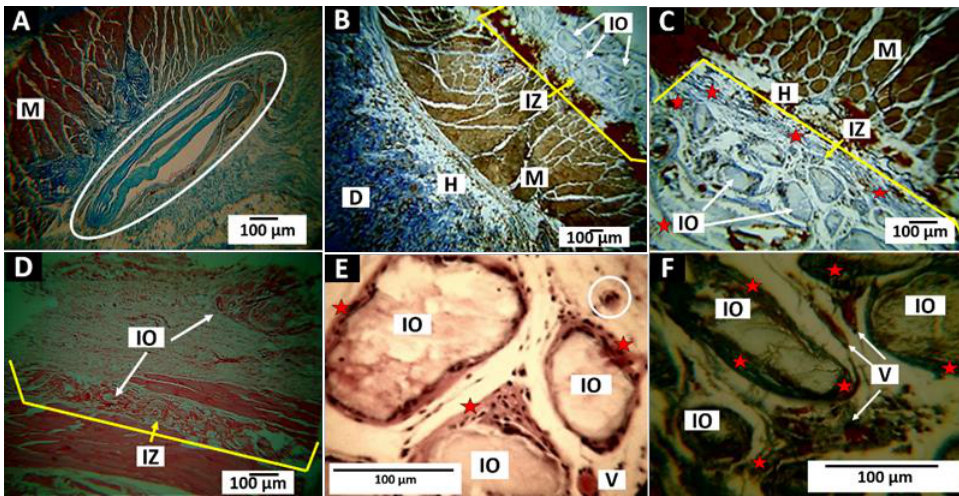
Figure 11. Subdermal implantation of F1 (InterOss). ( A ) image at 10×. MT technique. ( B ) Image at 4×. MT technique. ( C ) image at 10×. MT technique. ( D ) Image at 4×. H-E technique. A, B and C: MT technique. ( D ) Hematoxylin — Eosin technique. ( E ) 40× image, H-E technique. ( F ) Image at 40×. MT